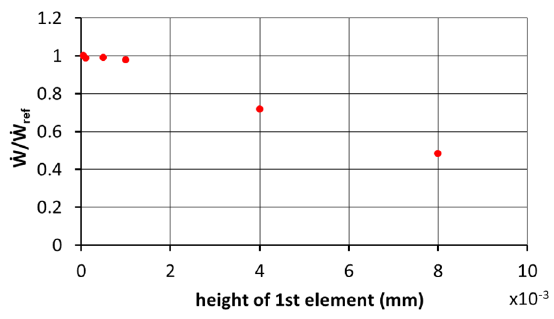
Figure 8. Boundary layer mesh study.